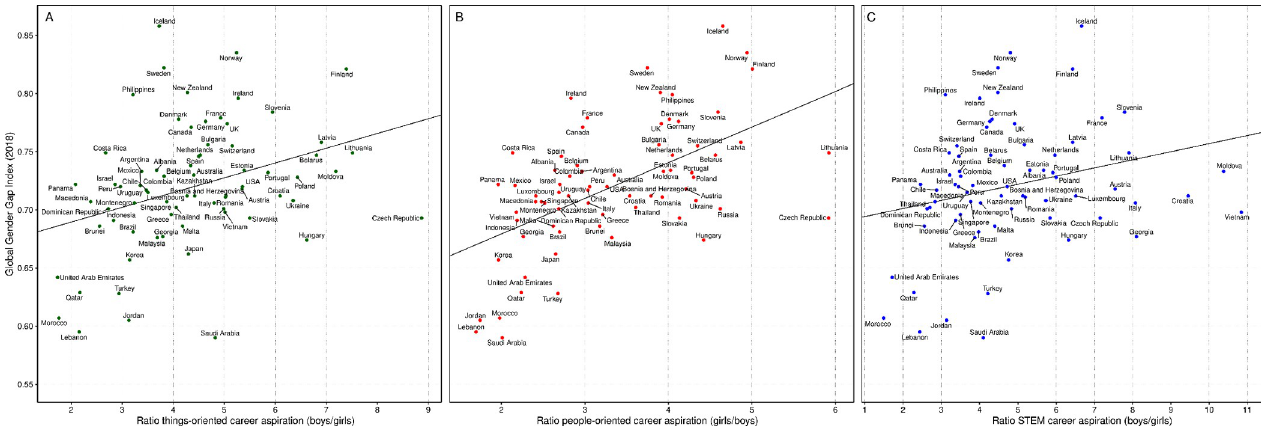
Fig 1. Ratios of boys to girls aspiring to work in things-oriented (green), people-oriented (red), and STEM occupations (blue). A: Each point represents the percentage of boys aspiring to work in a things-oriented occupation divided by the percentage of girls with the same aspiration and the country’s GGGI score. B: Like A, but now for the percentage of girls aspiring to work in a people-oriented occupation divided by the percentage of boys with the same aspiration. C: Like A, but now for non-organic STEM occupations only.